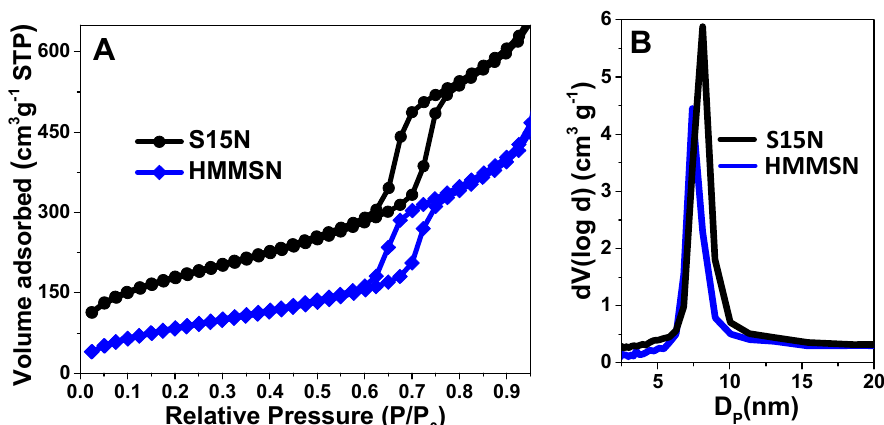
Figure 5. ( A ) N 2 sorption isotherms and ( B ) pore size distribution of the SBA-15 matrix and HMMSN hybrid magnetic mesoporous nanorods obtained from the BJH method.